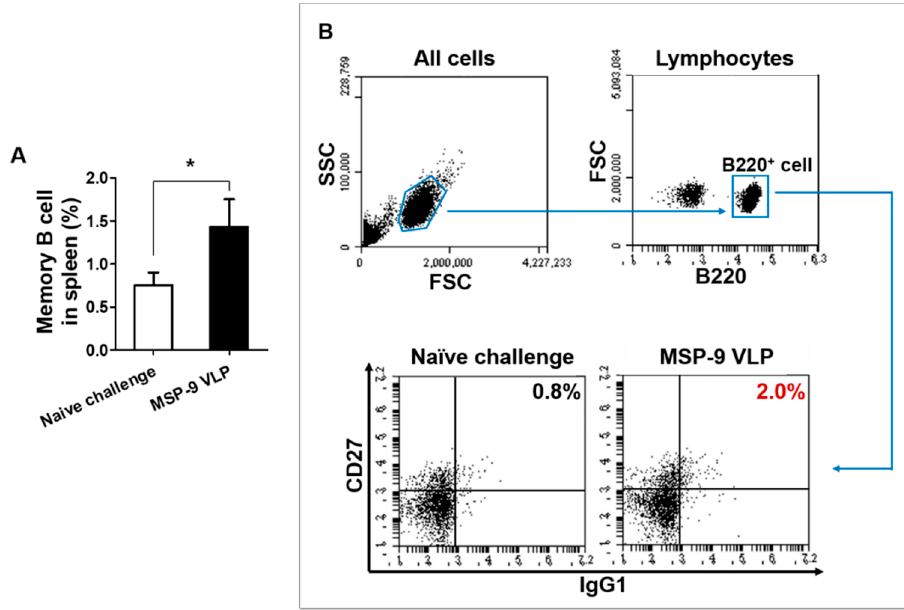
Figure 5. Memory B cell responses in spleen. Memory B cells were separated by CD45R/B220 + , CD27 + , and IgG1 + staining. A significantly higher level of memory B cells was found in MSP ‐ 9 VLP ‐ immunized mice (MSP ‐ 9 VLP) compared to naïve challenged mice (naïve challenge) ( A , * p <0.05). Flow cytometry plots showing the gating strategy to identify memory B cells ( B ). The error bars represent SEM.